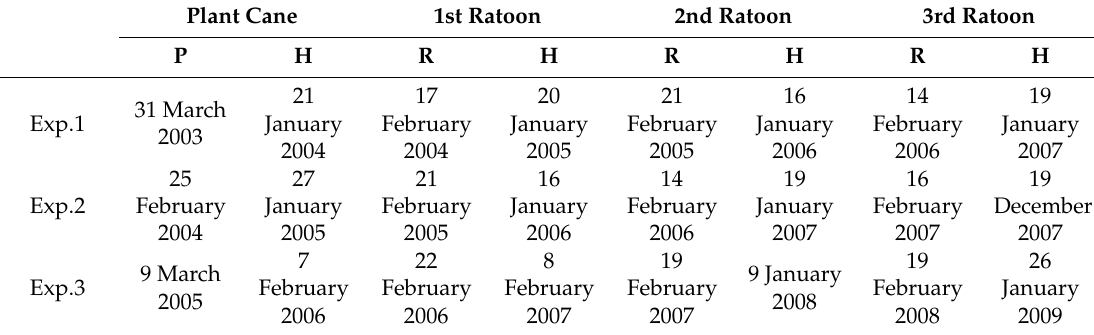
Table A2. Date of planting (P), harvesting (H) and ratooning (R) in field experiments (Exp.). Plant Cane 1st Ratoon 2nd Ratoon 3rd Ratoon P H R H R H R H